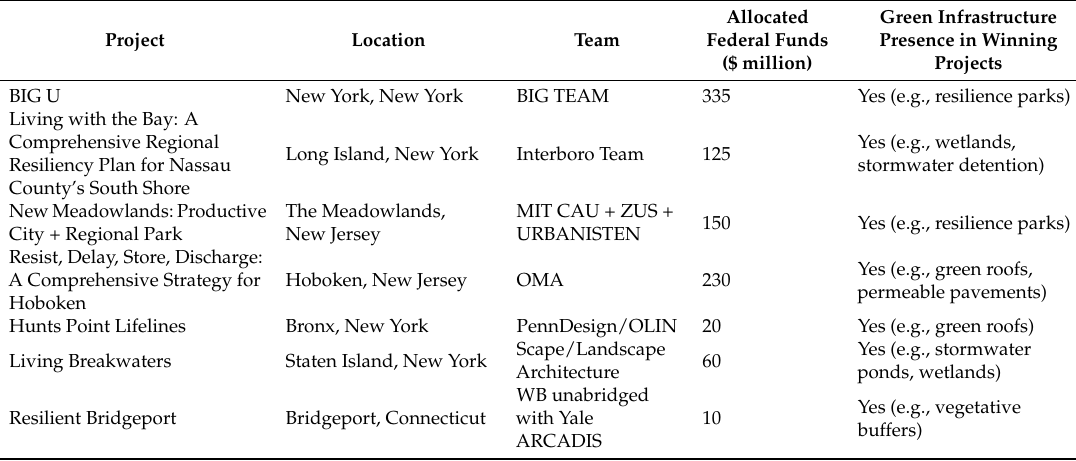
Table 1. List of projects that received funding for